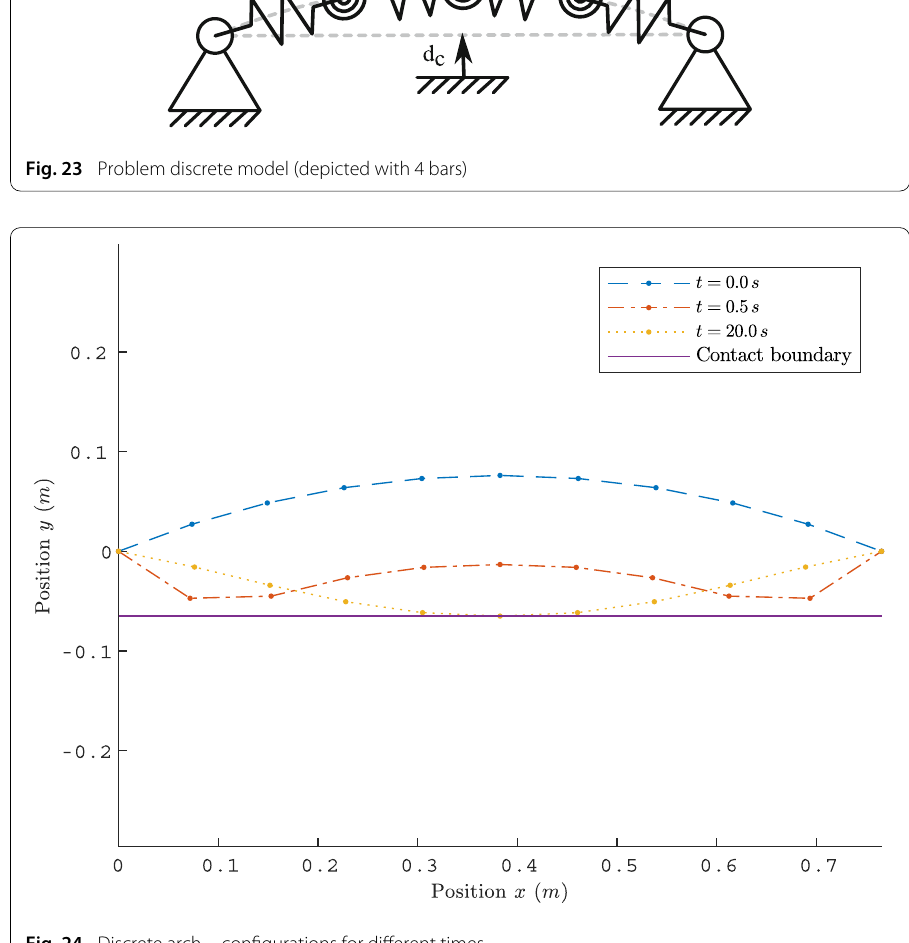
Fig. 24 Discrete arch—configurations for different